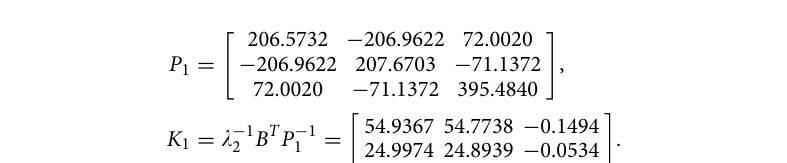
Figure 3. Curves of E